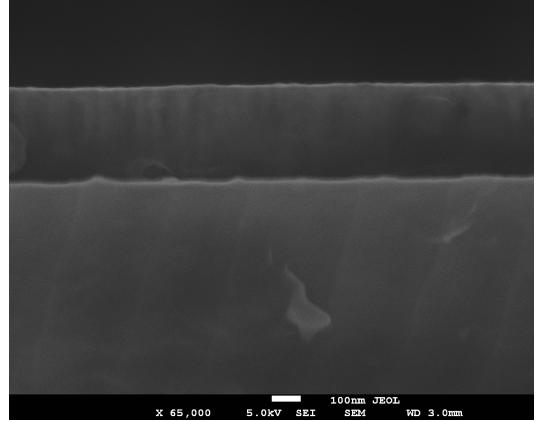
Figure 5. FEG-SEM image for ZrSiN_2 – it can be observed a morphology composed by non columnar